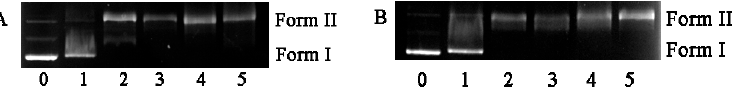
Figure 7. DNA photocleavage of pBR322 DNA dosed with complexes 1 , 2 , and irradiation (365 nm) for 1.5 h. Lane 0, DNA; Lane 1, DNA + Ru, no hv; Lane 25: 1 ( A ) at 20, 40, 60, and 80 µ M; 2 ( B ) at 10, 20, 30, and 40 µ M.